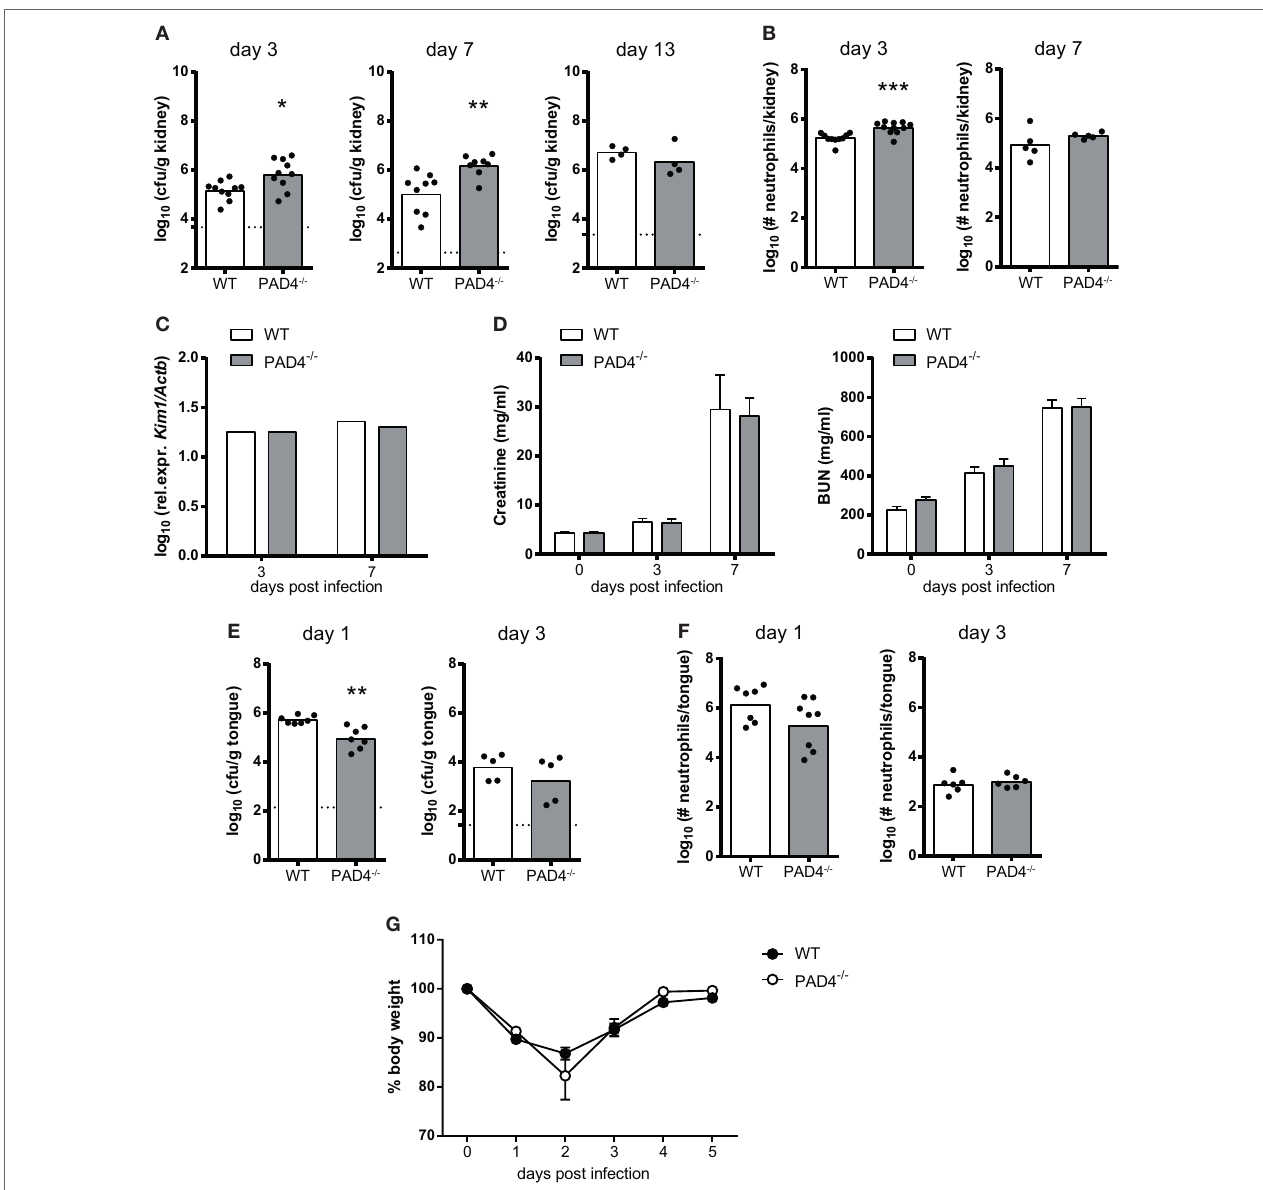
FigUre 5 | The role of peptidylarginine deiminase 4 (PAD4) during systemic and oropharyngeal candidiasis. (a–D) WT and PAD4 − / − mice were infected with Candida albicans via the tail vein. (a) The kidney fungal burden was determined on day 3, day 7, and day 13 postinfection. (B) CD45 + Ly6C int Ly6G + neutrophils were quantified in the kidney by flow cytometry on day 3 and day 7 postinfection. (c) Kidney injury molecule-1 (KIM-1) transcripts were quantified in kidney homogenates by qRT-PCR on day 3 and day 7 postinfection. (D) Creatinine and blood urea nitrogen levels were determined in the serum on day 3 and day 7 postinfection. (e–g) WT and PAD4 − / − mice were infected with C. albicans sublingually. (e) The tongue fungal burden was determined on day 1 and day 3 postinfection. (F) CD45 + Ly6C int Ly6G + neutrophils were quantified in the tongue by flow cytometry on day 1 and day 3 postinfection. (g) The body weight was monitored during the course of infection. In (a,B,e,F) , each symbol represents an individual mouse. The geometric mean (a–c,e,F) of each group is indicated. In (D) , the bars are the mean with standard error of the mean (SEM) of each group ( n = 8–10). Data are pooled from two to three independent experiments. The dotted lines in (a,e) represent the detection limit. See also Figures S2 and S3 in Supplementary